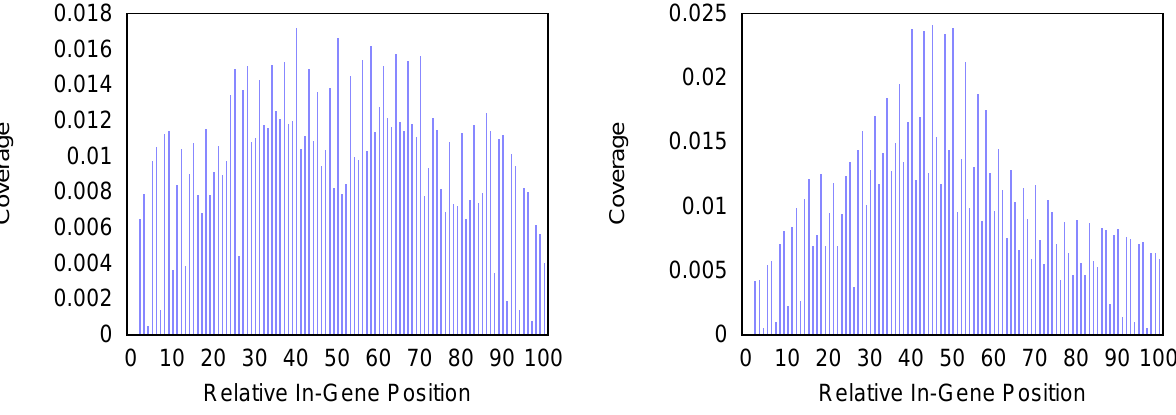
Figure 5. Density of the coverage with markers for gene trnF as detected by the annotation guided method (left) and the probability based method